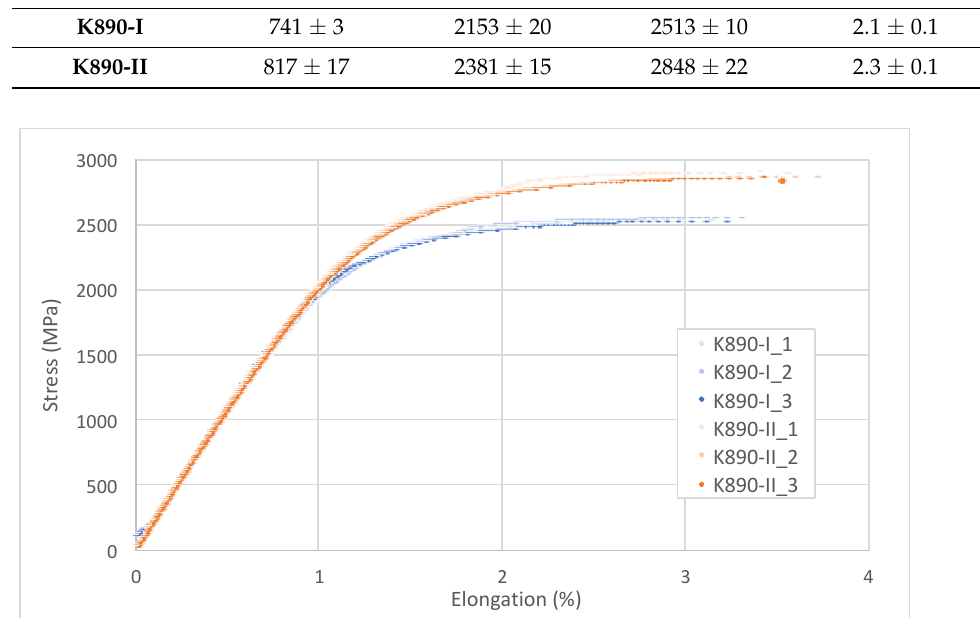
Figure 8. Comparison of stress-elongation curves of the K890 steel subjected to K890-I and K890-II heat treatments.